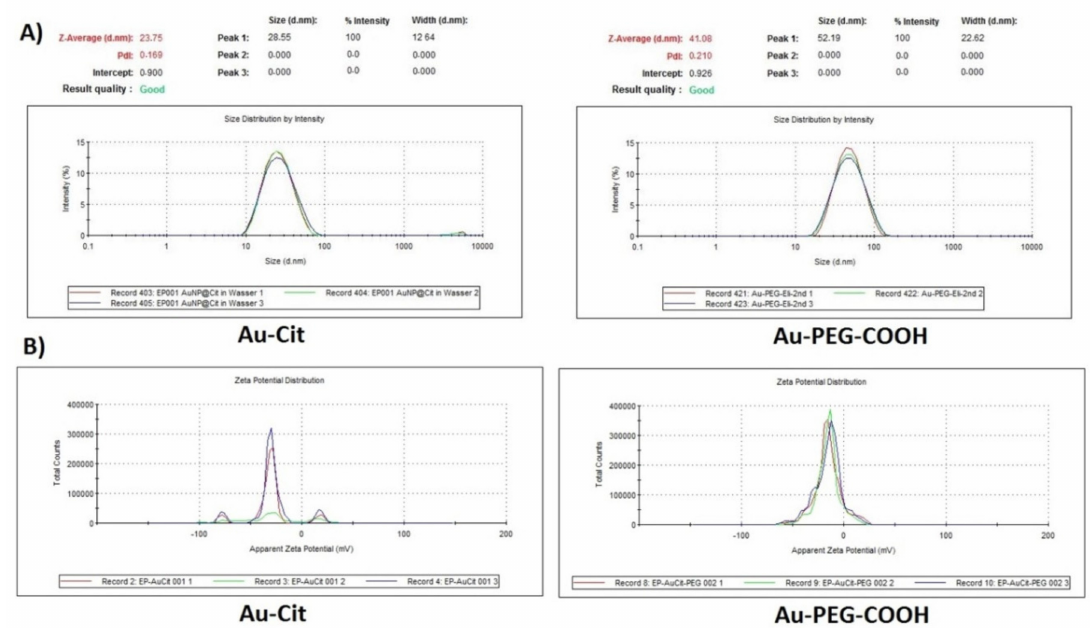
Figure 1. Characterization of gold nanoparticles. ( A ) DLS and ( B ) zeta potential of Au-Cit and Au- PEG-COOH in aqueous solution. The comparison shows that no aggregation occurs upon PEGylation of the citrate-covered